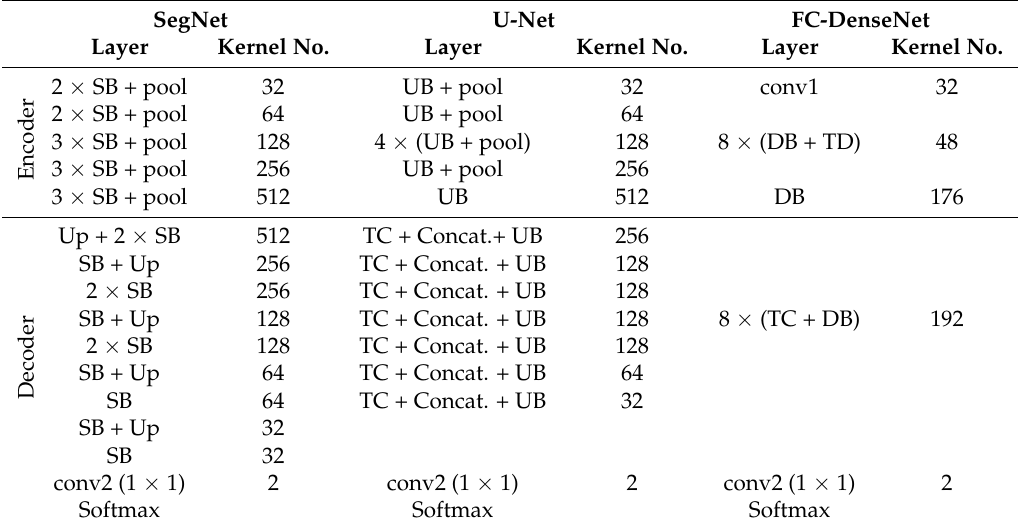
Table 1. Details of the SegNet, U-Net, and FC-DenseNet architectures used in the experimental analysis. SegNet U-Net FC-DenseNet